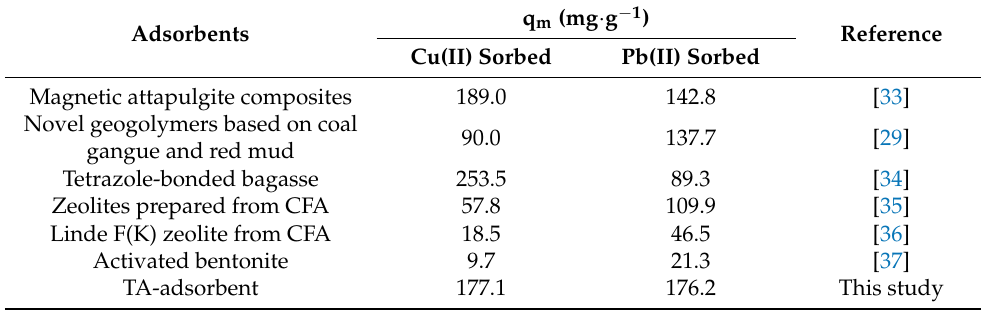
Table 4. Comparison of adsorption capacity of Cu(II) and Pb(II) by TA and other adsorbents. Adsorbents Magnetic attapulgite composites Novel geogolymers based on coal gangue and red mud